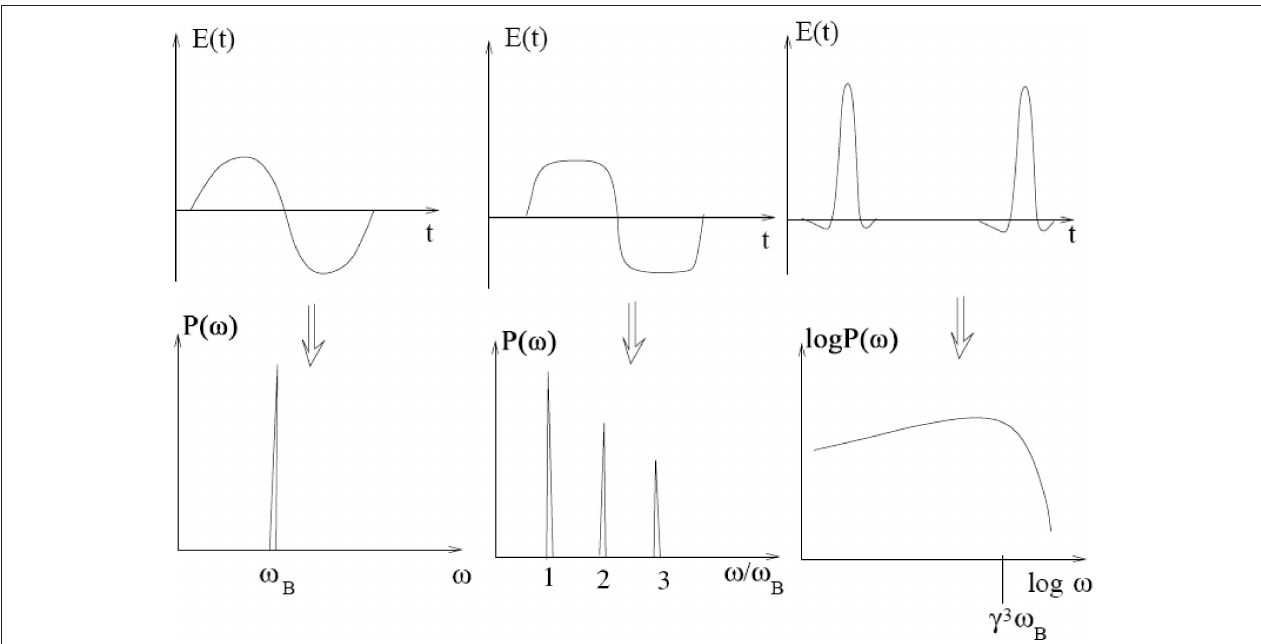
FIGURE 5 | Top : Schematic time variability of the detected electric field that has been produced by a gyrating electron in the cases of small speed (left panel), thermal speed (middle panel) and relativistic speed (right panel). Bottom : Schematic power spectra resulted from the cases of the top row.